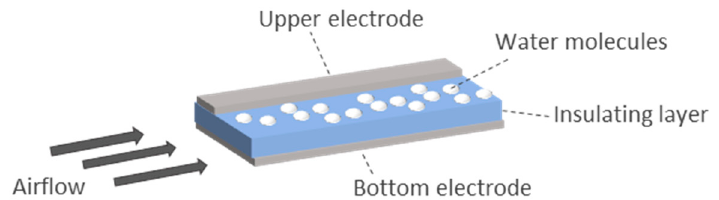
Figure 16. Electrostatic energy harvesting based on the variation of the area of the upper electrode owing to humidity of the exhaled air (figure inspired by Reference [248]).